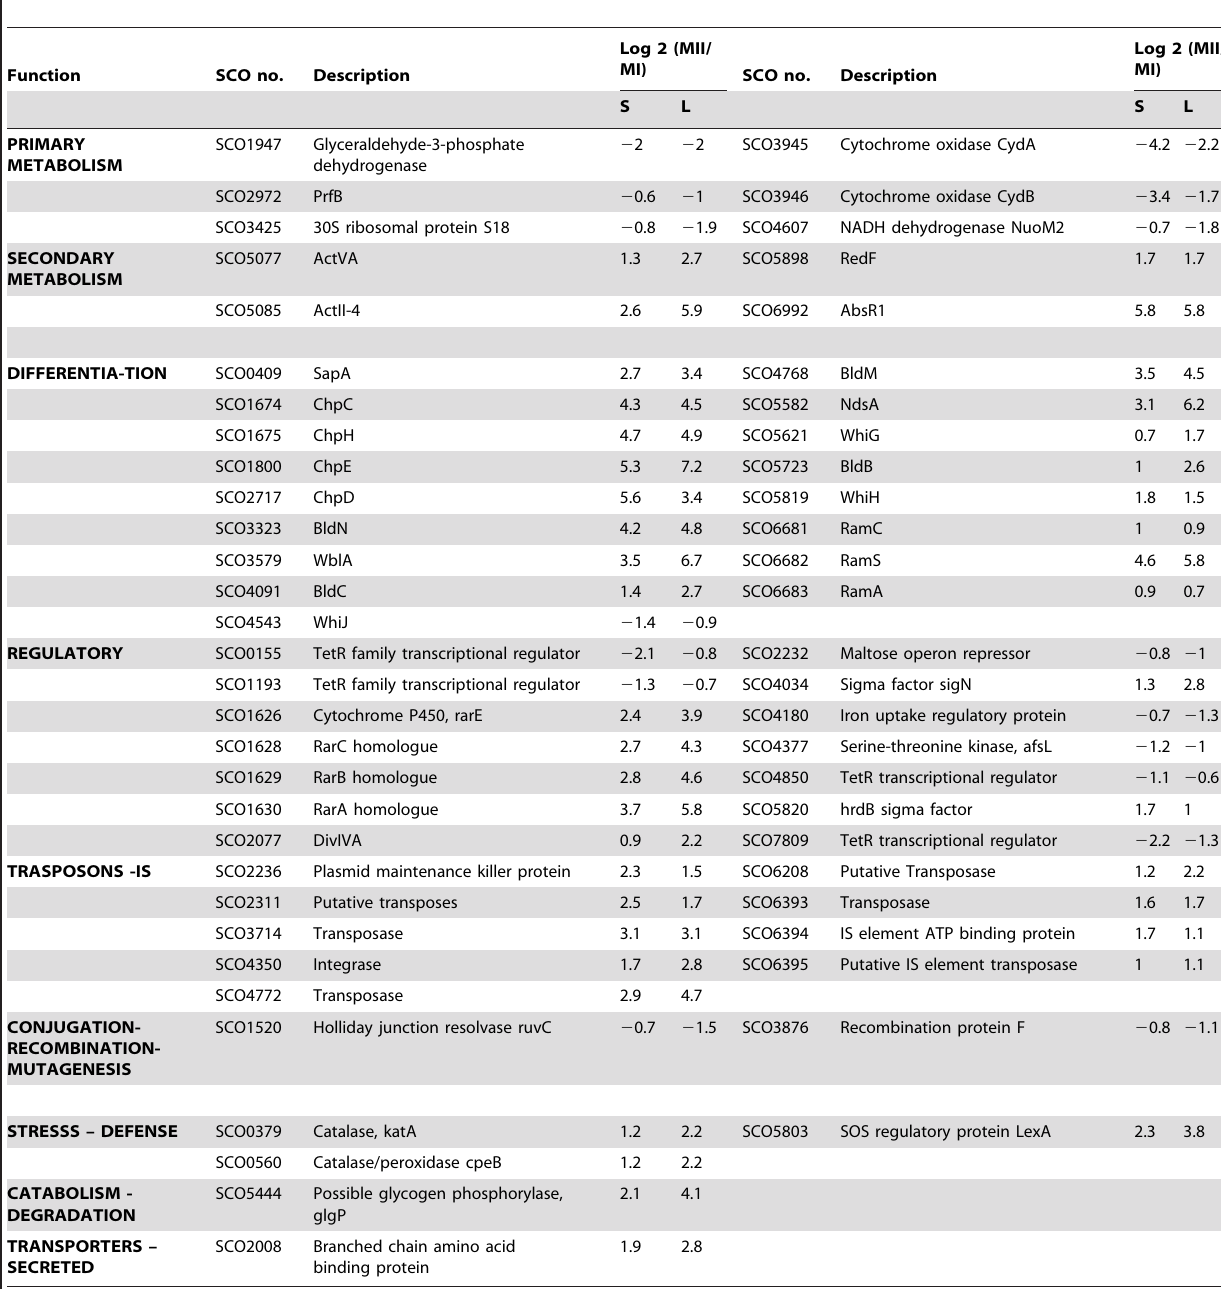
Table 3. Summary of well characterized genes whose transcripts showed similar abundances in liquid and solid cultures (coefficient of variation between liquid and solid cultures lower than 0.7) (Fig. 4A, D, G, J, M, P, S; Fig. 5A, D, G, J).